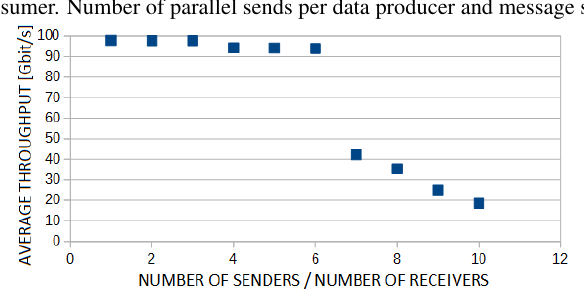
Figure 3. Arista DCS-7280CR2K-30-F switch (top) versus Juniper QFX10000-30C (bottom) results with average data producers throughput of the DAQPIPE parameter scan for 8 parallel transmission grants per data consumer. Number of parallel sends per data producer and message size were adjusted.